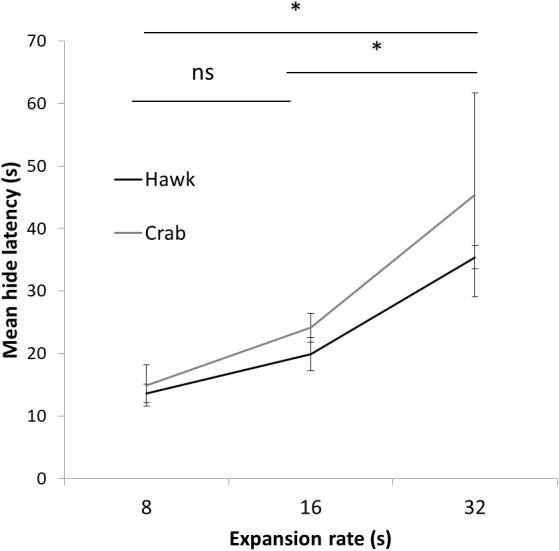
Results Experiment 2.Mean latency (s) to hide to the 8 s, 16 s, and 32 s presentation time stimuli using both a Hawk and Coconut Crab image in Experiment 2. Error bars depict standard errors of the means.